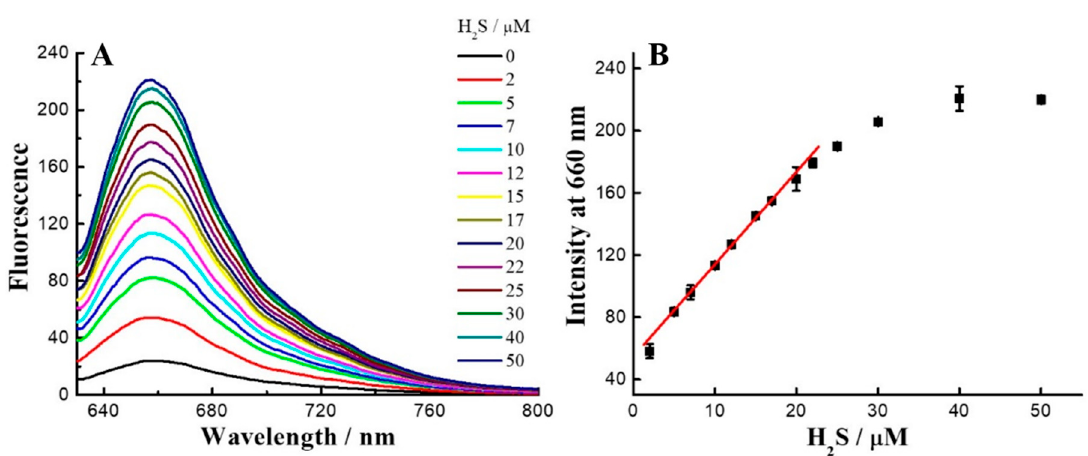
Figure 3. ( A ) The fluorescence changes of probe 1 (2 μ M) responses to various concentrations of H 2 S (0–50 µM) in PBS (50 mM, pH 7.4, containing 10% DMSO). ( B ) The linear relationship between concentrations of H 2 S and emission at 660 nm. The detection limit was calculated to be 0.27 μ M.